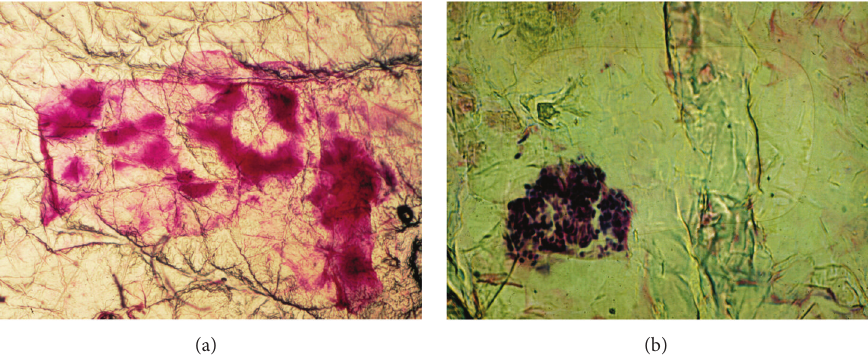
Figure 7: Spongiotic-parakeratotic disorders. (a) Pityriasis rosea with small serum deposits. (b) Clump of neutrophils in active